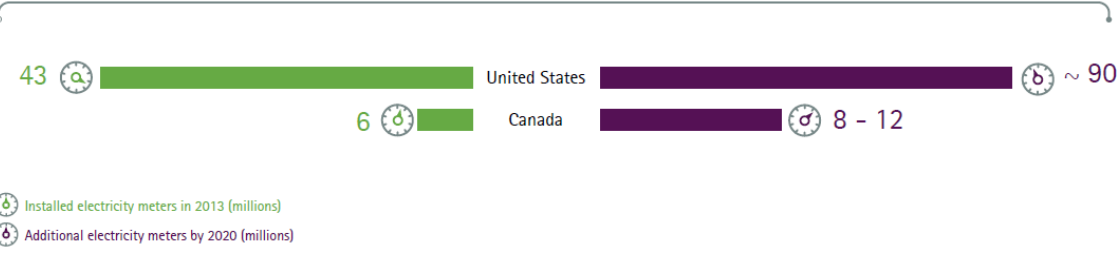
Figure 6. Estimation of the total number of SM s installed in North America by 2020 (Source: Accenture [55]). Reprinted with the permission of Accenture, “Realizing the Full Potential of Smart Metering ”, published by Accenture, 2015.